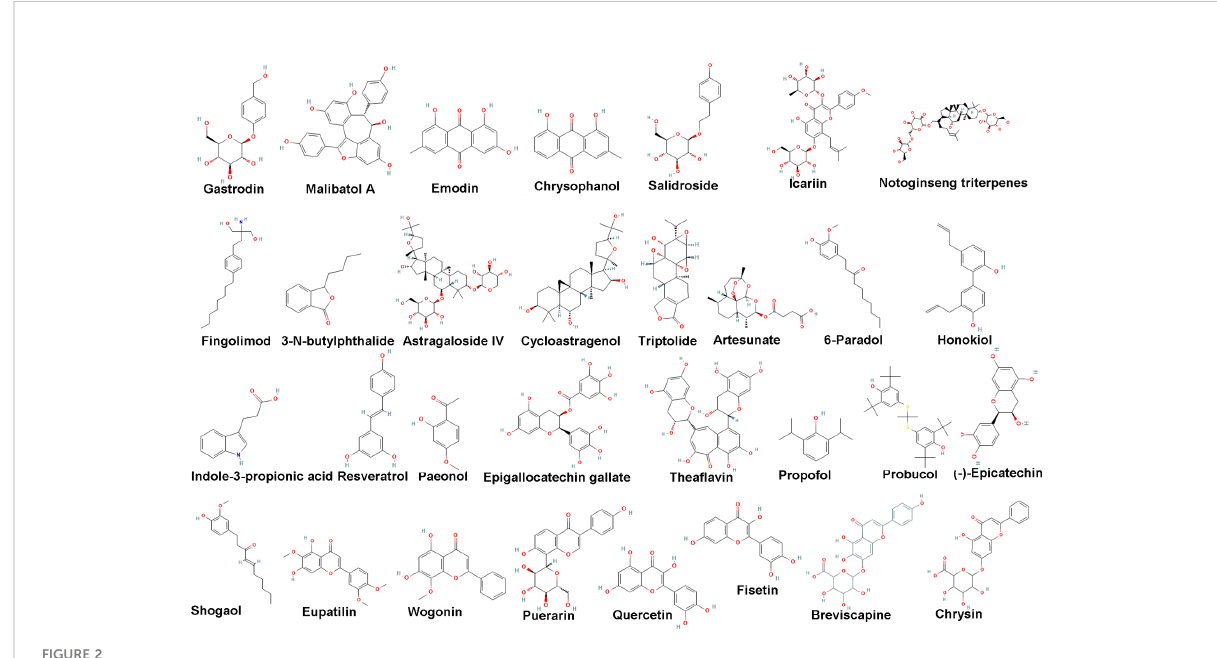
FIGURE 2 The structure of main natural botanical